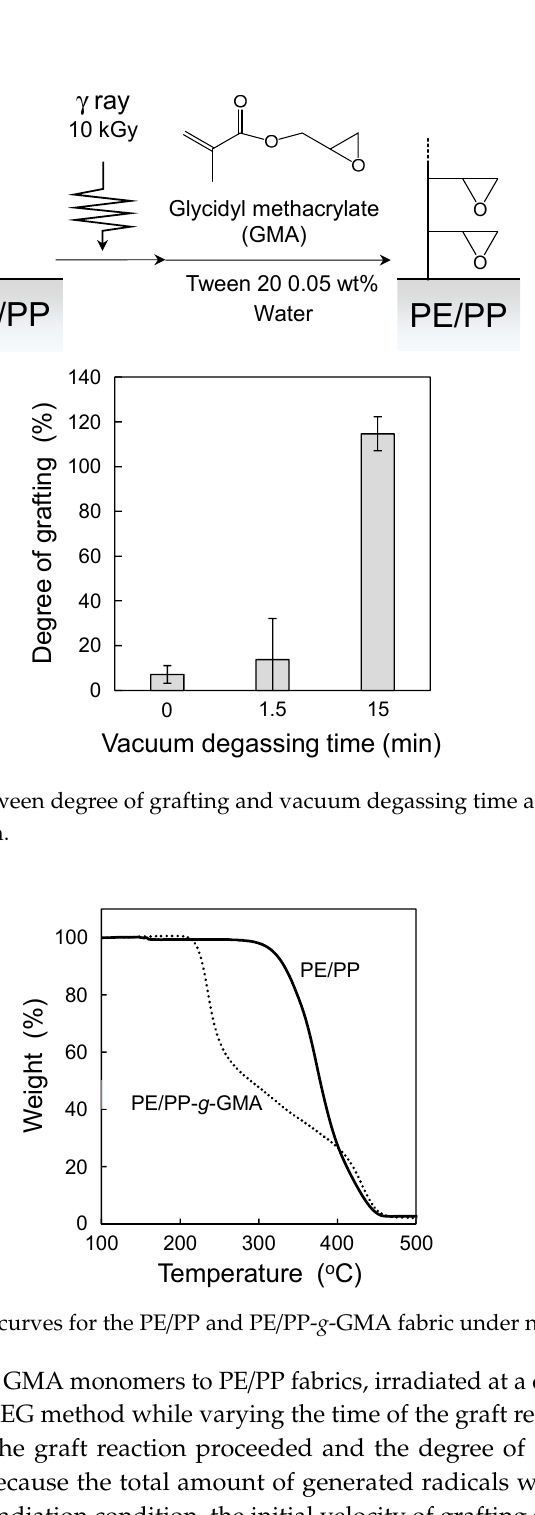
Figure 3. TGA curves for the PE/PP and PE/PP- g -GMA fabric under nitrogen.